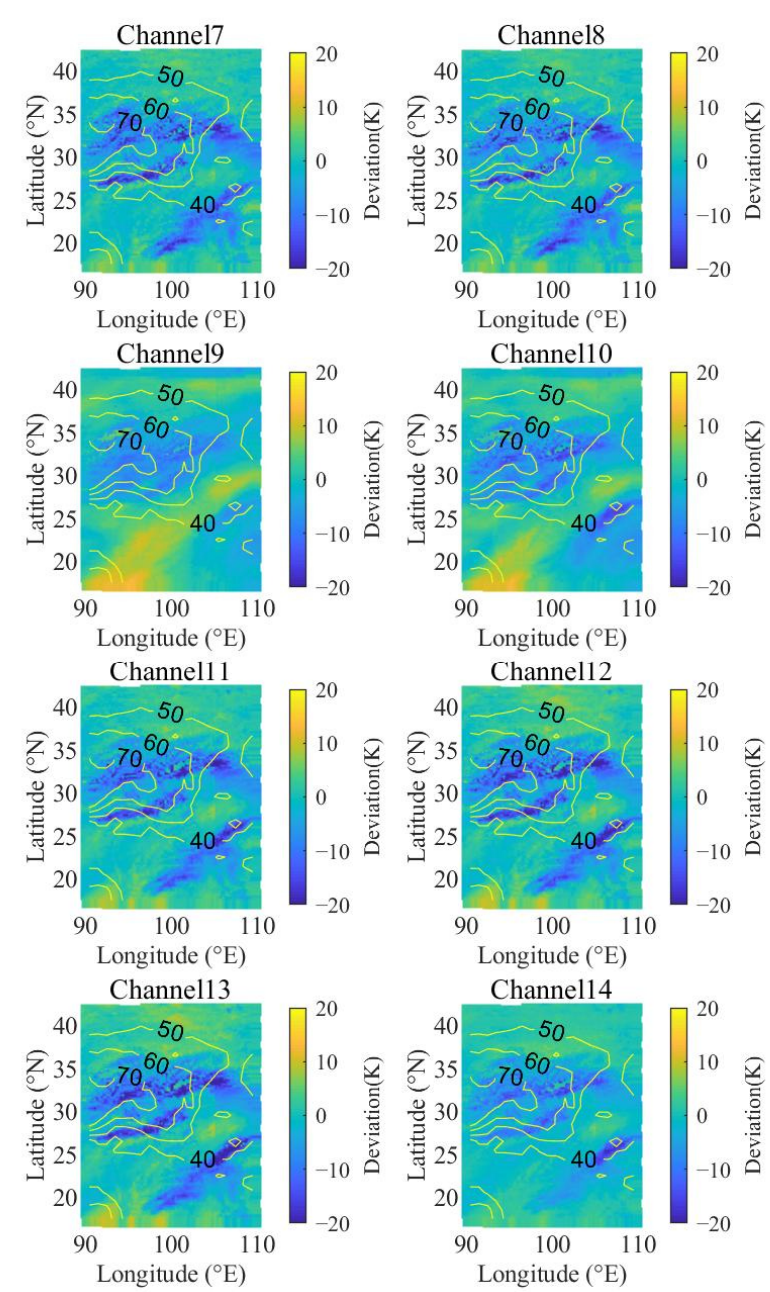
Figure 6. The deviation images on 30 January